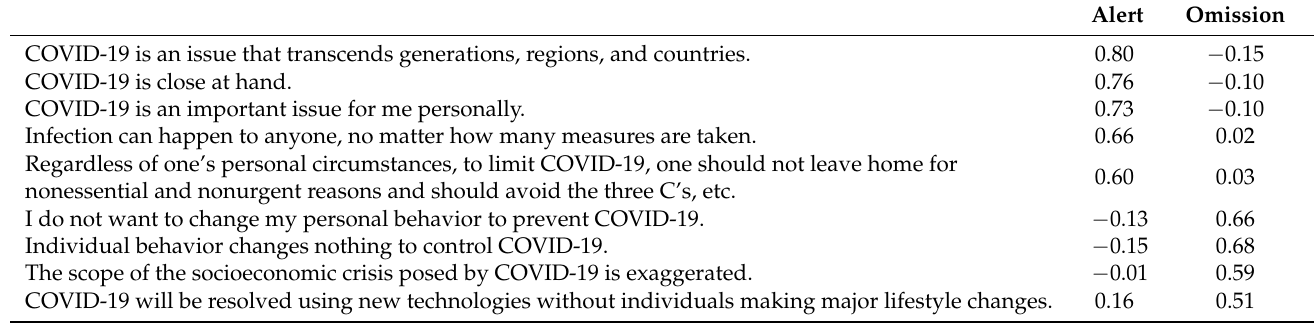
Table 3. Results of factor analysis of COVID-19 recognition.